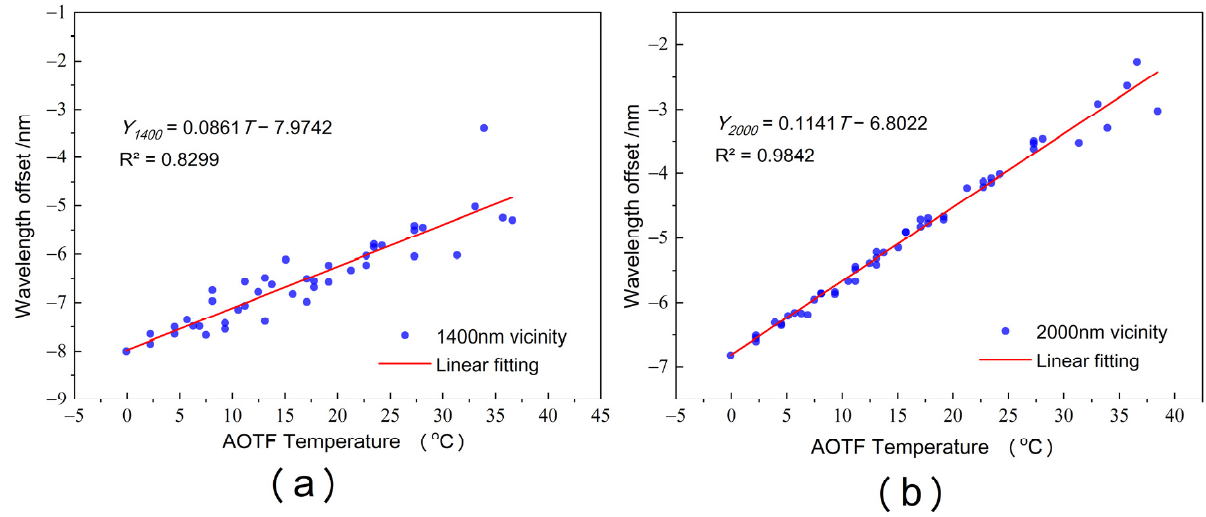
Figure 5. Correction coefficients with AOTF temperature fitted. ( a ) Correction coefficients fitted in the central wavelength absorption spectrum of around 1400 for CO 2 . ( b ) Correction coefficients fitted in the central wavelength absorption spectrum of around 2000 for CO 2 .